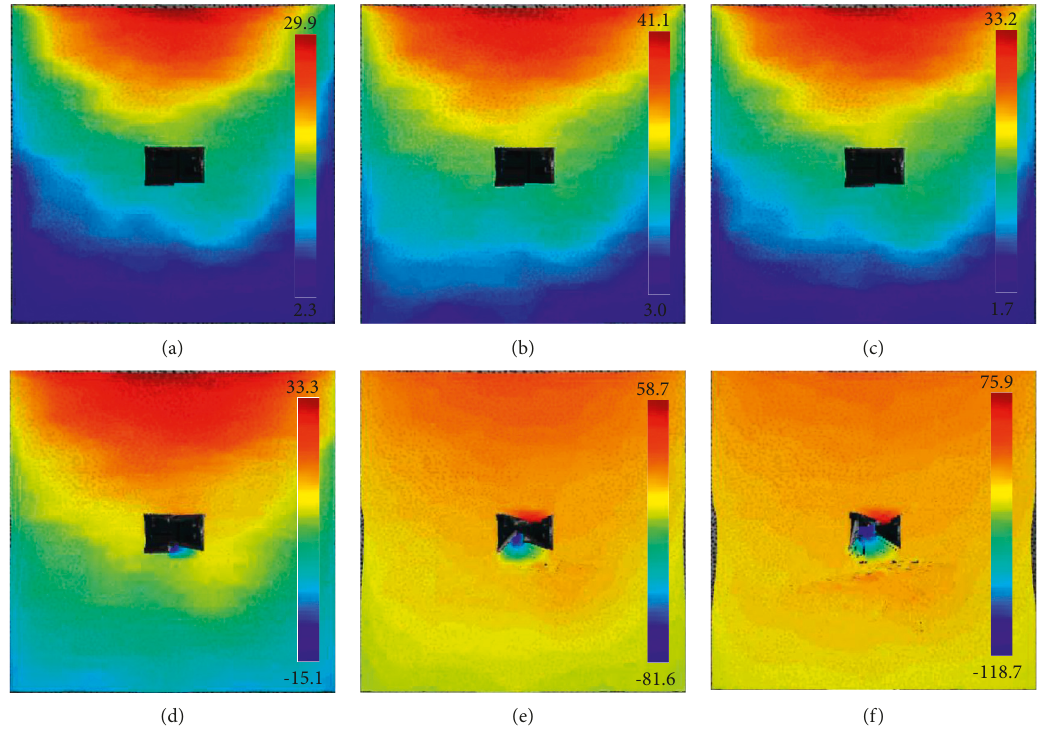
Figure 5: Evolution of vertical displacement field under different loads; (a) Under load level 4; (b) Under load level 14; and (c–e) Under load level 23 and cumulative duration is 541 mins, 542mins, 543mins and 544mins, respectively. (unit: